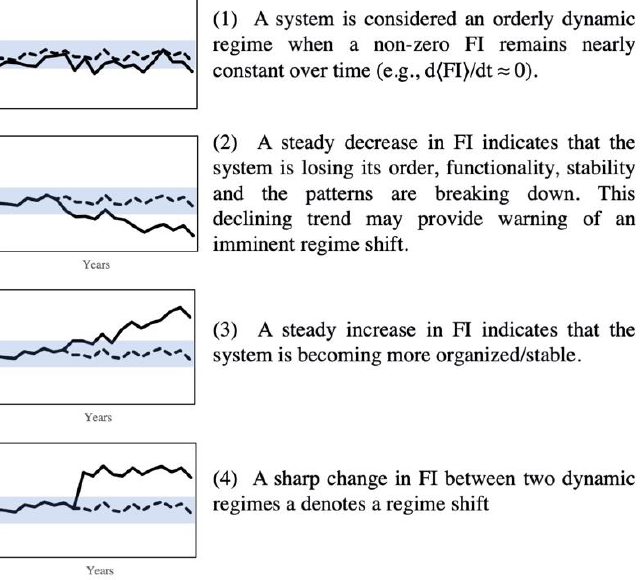
Table 1. Statistical comparison of the estimated natural flows and the available studies of Orive de Alba [38], Loredo-Rasgado [37], and Blythe and Schmidt [33]. Orive-Alba Loredo-Rasgado Blythe and Schmidt Goodness of Fit Criteria Pearson’s Correlation 0.990 Coefficient of Determination (R 2